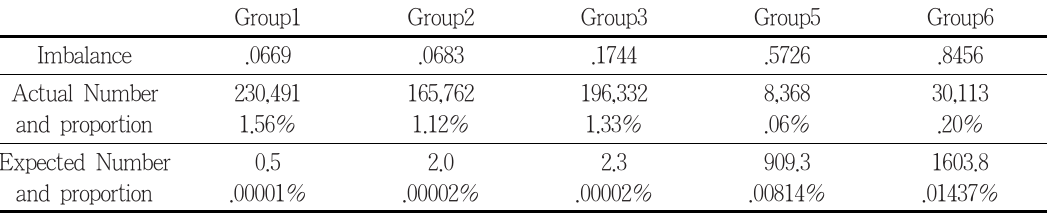
<Table 5> The imbalance, and actual vs. expected number of membership for each social hub